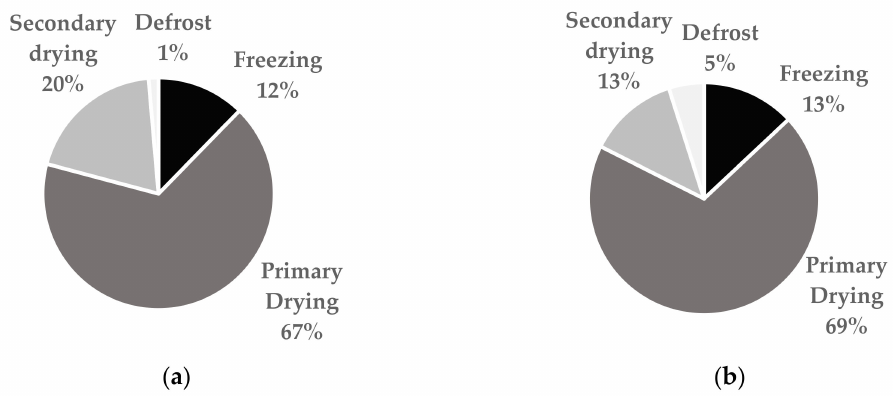
Figure 2. Percentage distribution of the operational costs (OC) of the fundamental steps of a